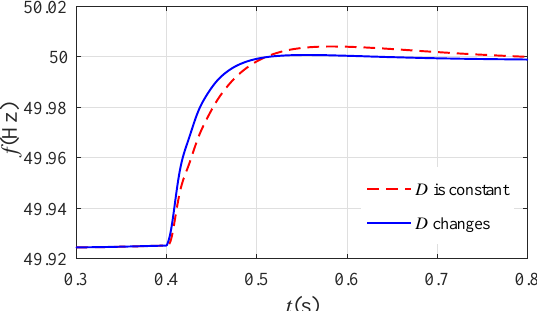
Figure 16. Frequency response under different virtual damping when connected to the grid.